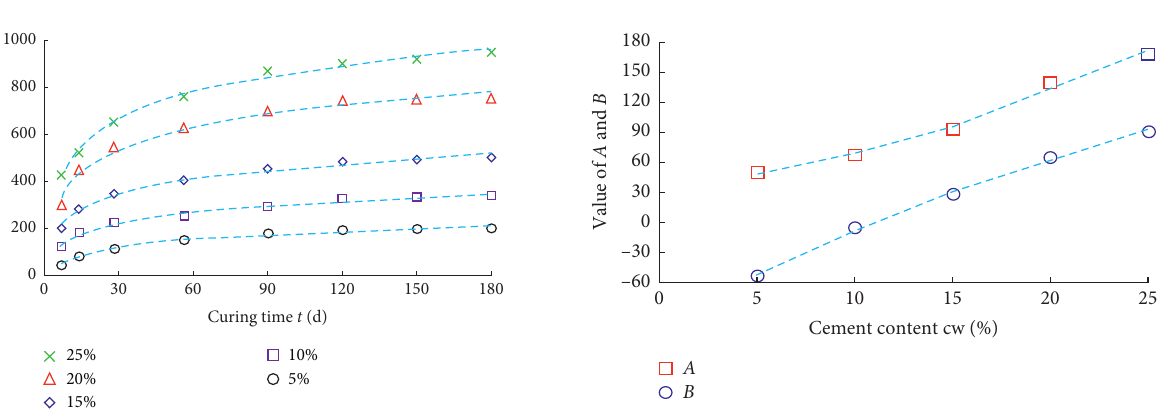
Figure 11: The UCS and curing age curve of the CMS with different cement contents.